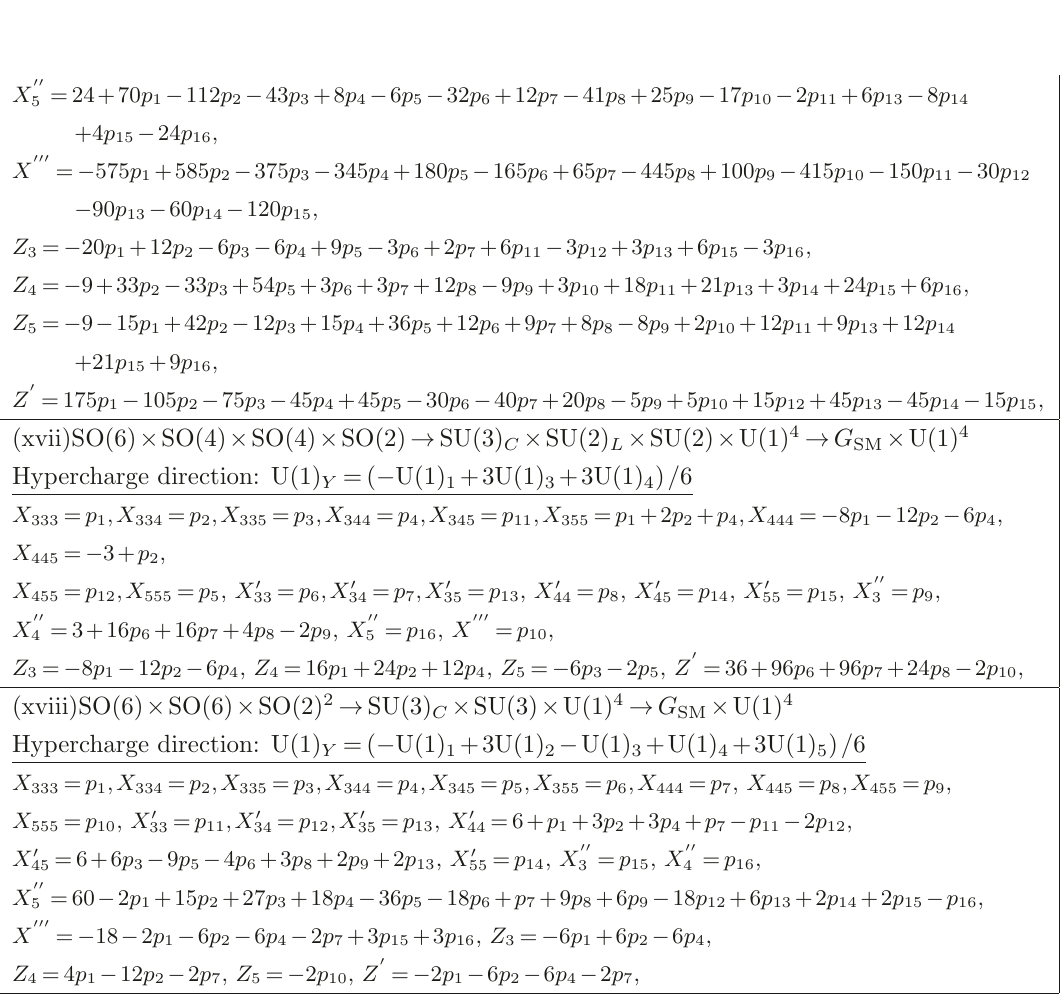
Table 2 : The list of 24 variables generation models on simply-connected CY threefolds. We now choose a specific hypercharge direction for